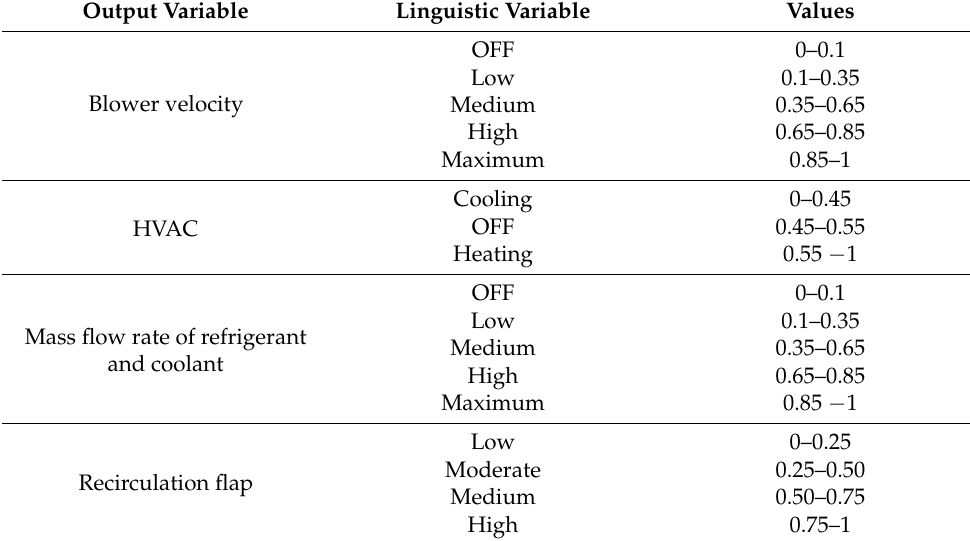
Table 4. Fuzzy controller input linguistic values for membership